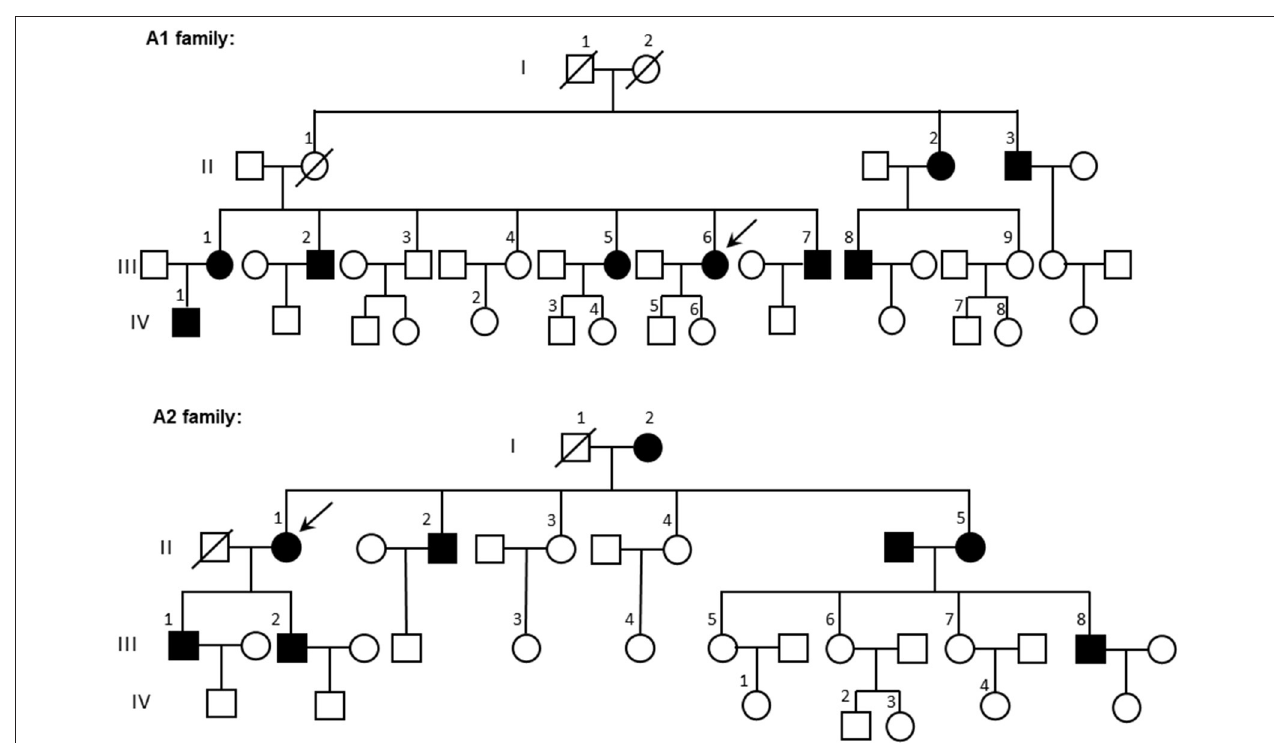
FIGURE 2 | Family trees of pedigrees A1 and A2. Patients with hypertension are in black; the arrow indicates the proband. ◦ , female; 2 , male.